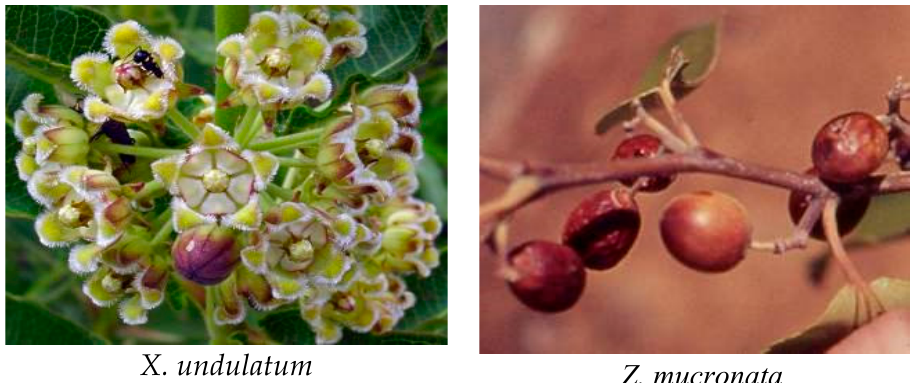
Figure 4. Medicinal plants used traditionally to treat tuberculosis in Mpumalanga Province. Pictures obtained from SANBI [85].